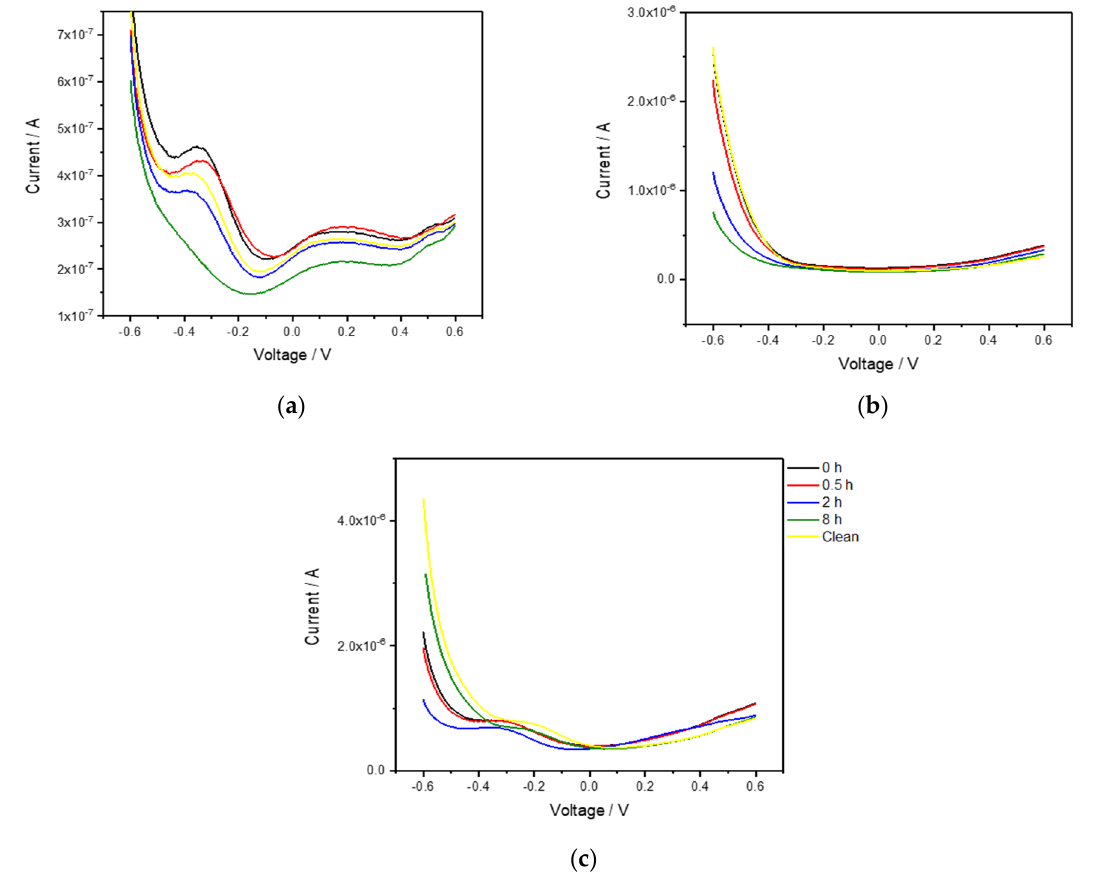
Figure 4. Differential pulse voltammetry (scan rate 20 mV/s, pulse amplitude 25 mV, pulse time 50 ms) of ( a ) gold, ( b ) platinum, and ( c ) palladium electrodes incubated in the same sweat solution with measurements taken immediately, after 0.5 h, 2 h, 8 h and finally after cleaning the electrodes and measuring again in the same